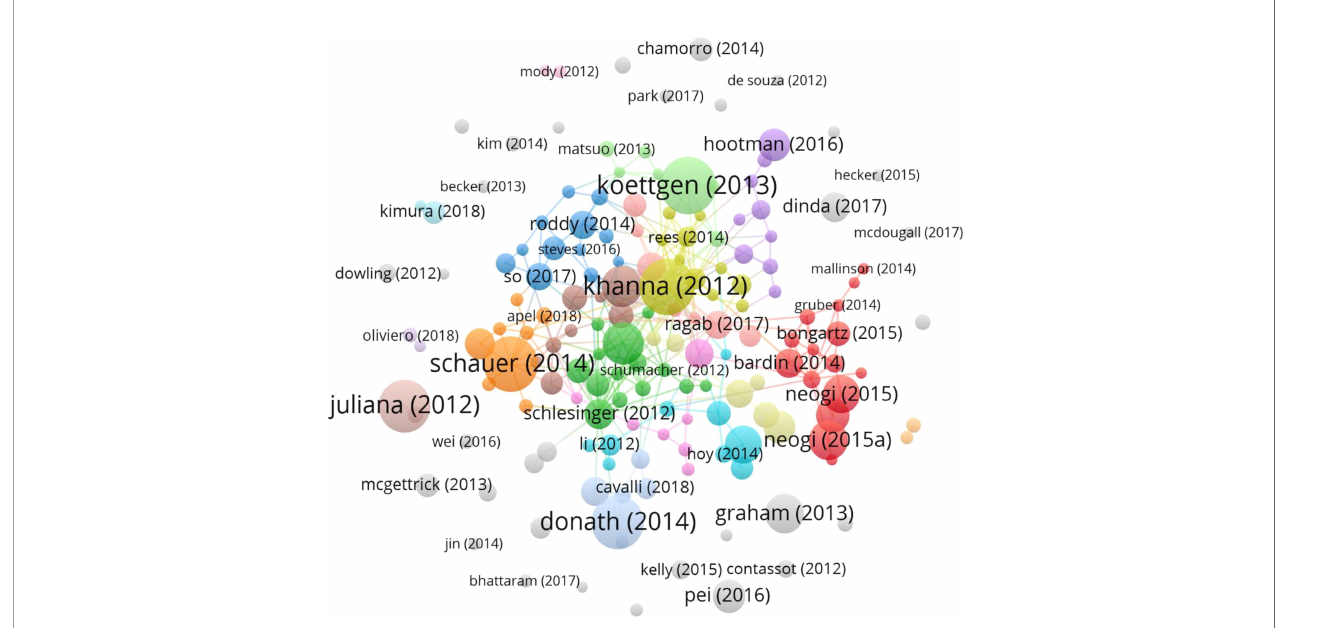
FIGURE 5 | Network of document citation. Given a large number of references available, the minimum number of citations for a reference was placed at 50. 161 of the 2052 papers were chosen for citation analysis. The different colours of the nodes represent different documents, with larger nodes meaning more frequently cited